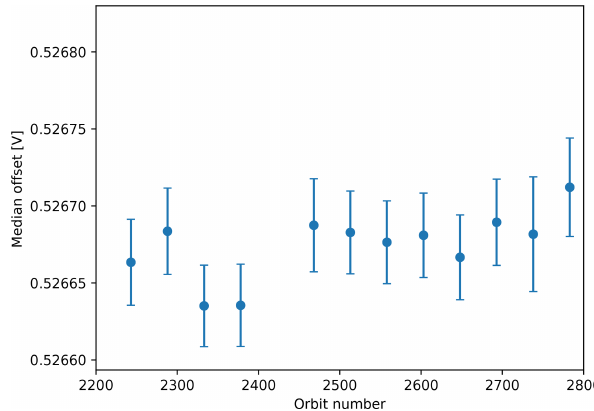
Figure 9. The median offset and its uncertainty obtained with the FMM closed during the E1 phase between orbits 2200 to 2800 as a function of